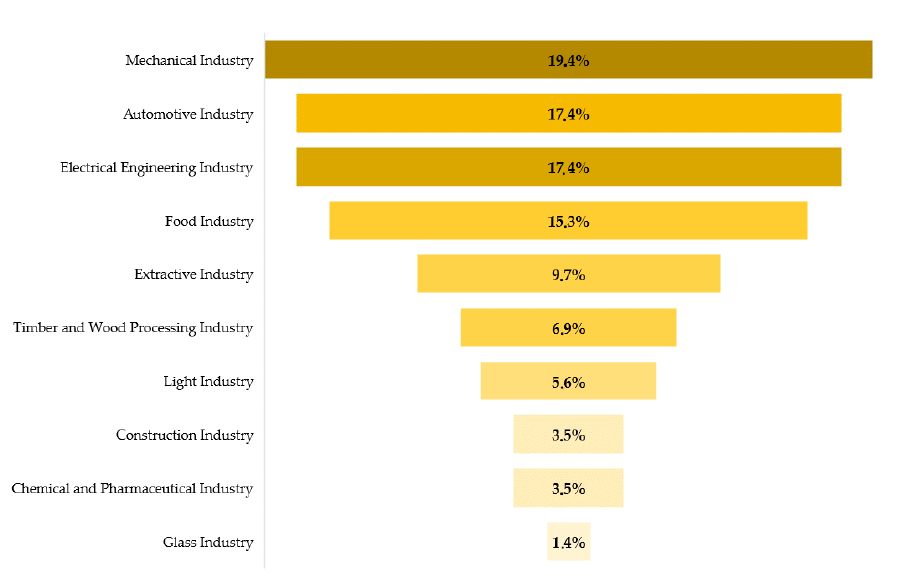
Figure 3. Data file structure by regions of Slovakia. Source: Author's own.